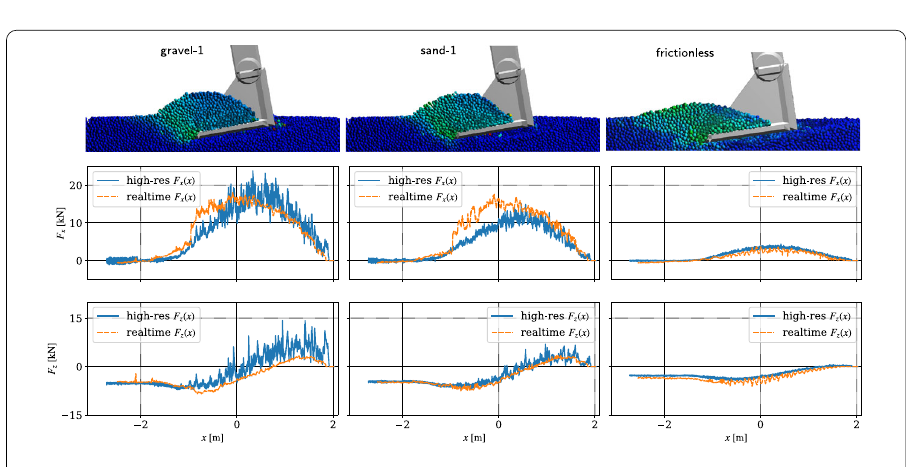
Fig. 14 Simulated excavation for comparing the multiscale terrain model (left) and the microscale reference model (right, particles colour coded by particle height position) at time 8 s and using material dirt-1 . Second and third row show sideview of the high-resolution model (particles colour coded by velocity, blue to red by 0 to 1.5 m/s) and the real-time model, at time 0, 2, 4, 6, 8, 10 and 12 s. See Additional file 4: Video S4